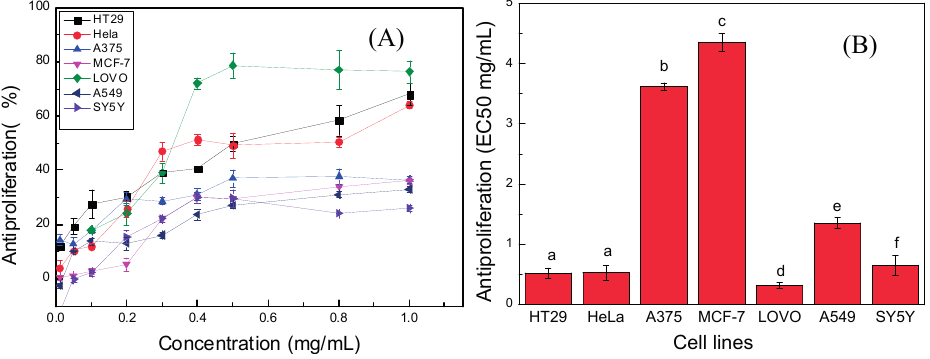
Figure 3. Antiproliferative effects of PPP on seven cancer cells. ( A ) Inhibition of seven cells proliferation with treatment of different concentrations of PPP; ( B ) The EC 50 values for the inhibition of seven cells growth by PPP. Results were represented as means ± standard deviation of three parallel measurements followed by the different letters, which indicated significantly different ( p < 0.05), ( n =